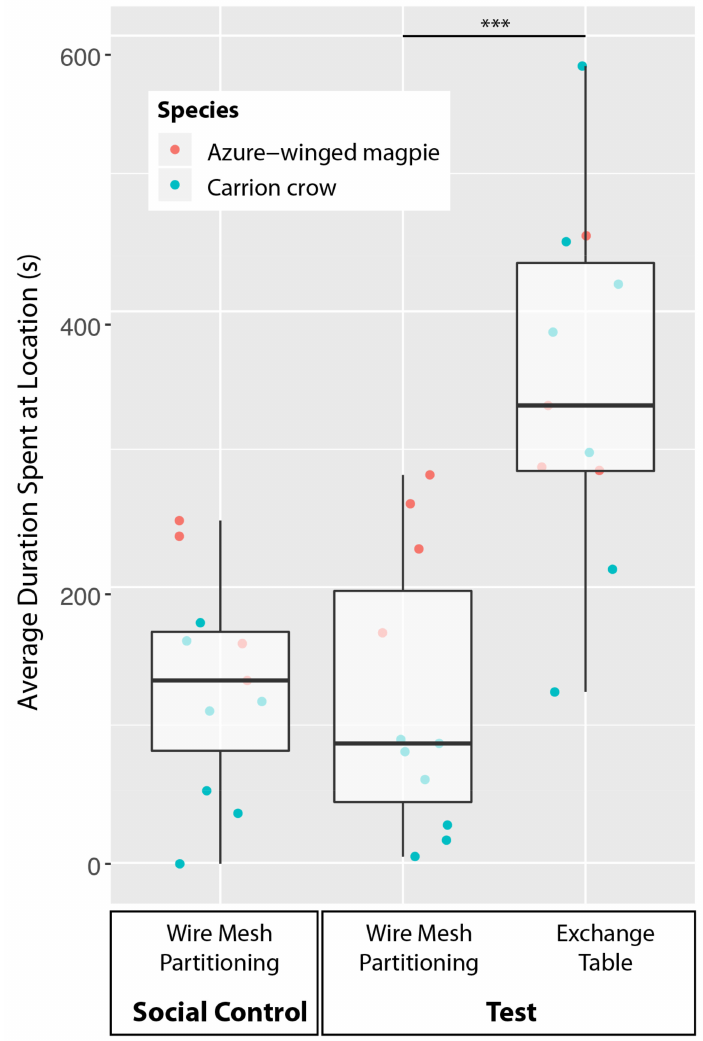
Figure 2. Duration that one or more recipients spent at the given locations averaged from the first two sessions of each donor individual per condition. The box plots represent the medians (horizontal lines), inter-quartile ranges (boxes), as well as minima and maxima (whiskers). All of the data are represented with dots. The dot colors indicate the species according to the legend in the top left corner. *** p ≤